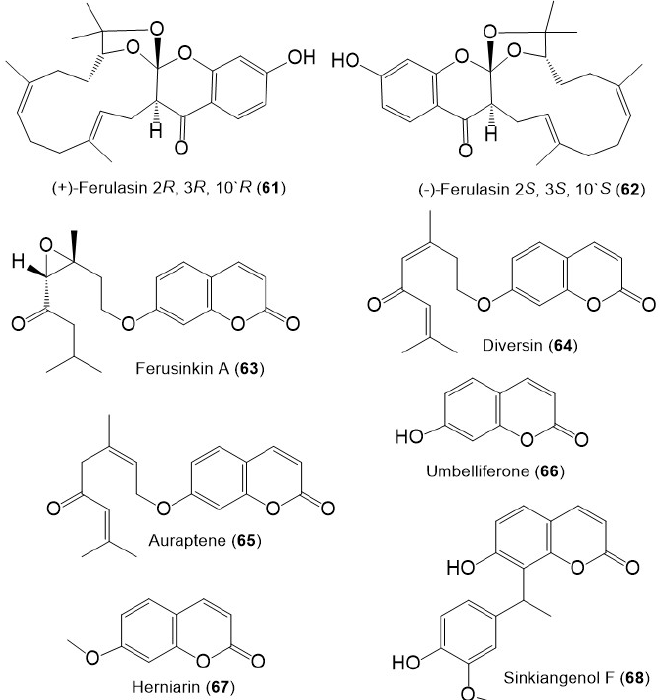
Figure 9. Structures of sesquiterpene chromones ( 61 and 62 ), monoterpene coumarins ( 63 – 65 ), and coumarins ( 66 – 68 ) from F. sinkiangensis .